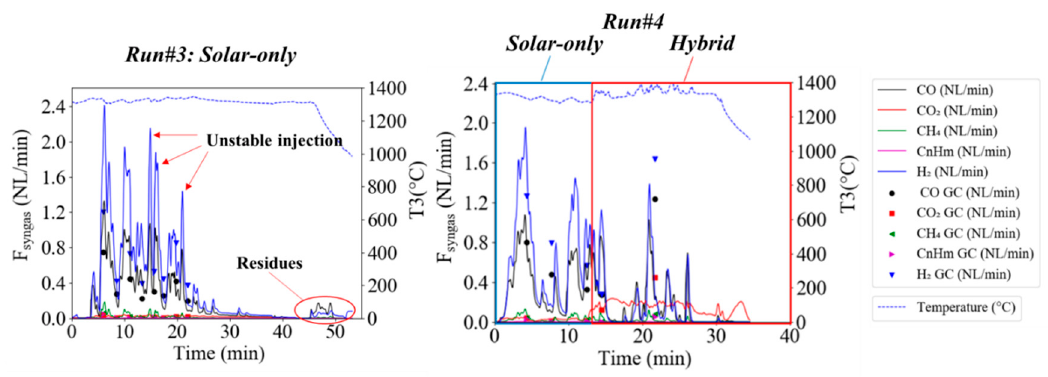
Figure 6. Syngas flow rates in Run#3 (solar-only) and Run#4 (hybrid) and T3 temperature in °C. Just as in Run#1 (using beech wood particles), H 2 and CO flow rates were the highest, followed by CO 2 , CH 4, and C n H m . GC measurements of the C n H m are shown in Figure 7. They were primarily composed of C 2 H 2, whereas C 2 H 4 and C 2 H 6 were found in negligible amounts.